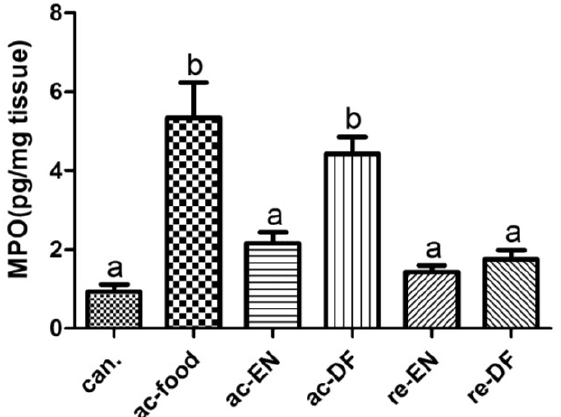
Figure 8. The expression of myeloperoxidase (MPO) in colon mucosae from different groups (pg/mg tissue) (can. 0.94 ± 0.38, ac-food 5.34 ± 2.00, ac-EN 2.16 ± 0.64, ac-DF 4.43 ± 0.95, re-EN 1.44 ± 0.35, and re-DF 1.76 ± 0.51). Columns with different letters are significantly